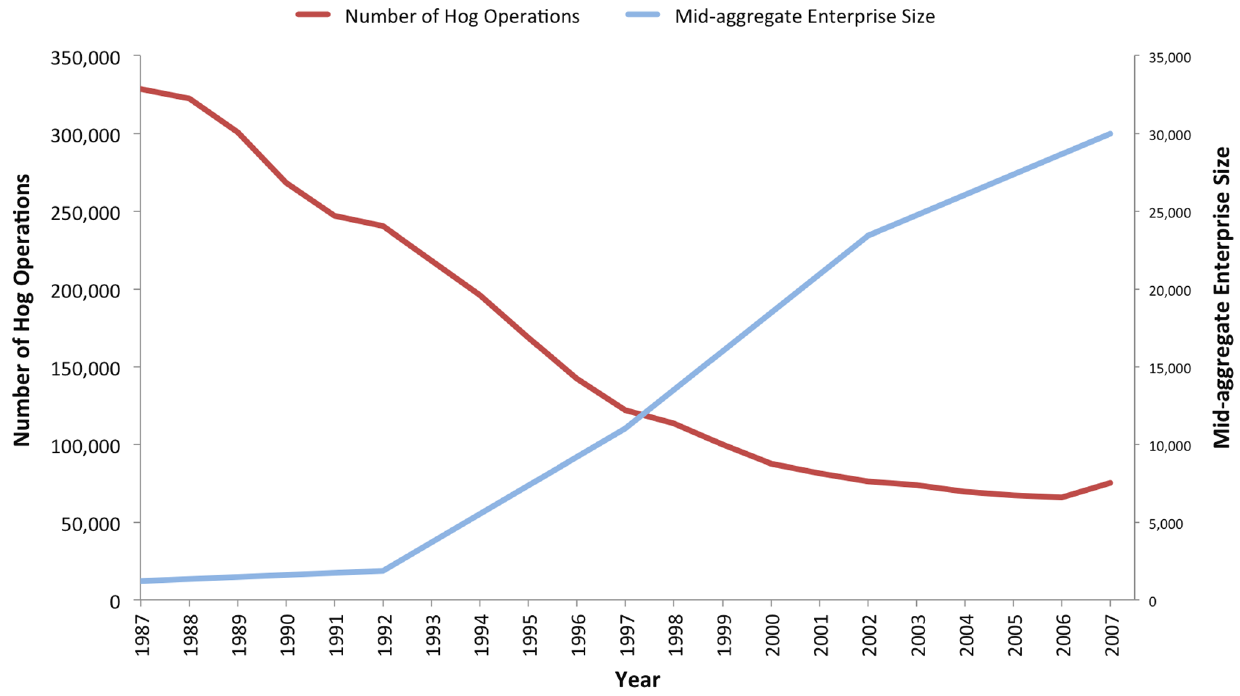
Figure 1. Hog production in the US: Number of operations and mid-aggregate enterprise size; 1987–2007. Data from the United States Department of Agriculture (USDA) shows the decline in number of hog operations and growth in operation size from 1987 to 2007. Sources: The Changing Organization of U.S. Farming, USDA Economic Research Service (http://www.ers.usda.gov/amber-waves/2011-december/changing- farming-practices.aspx # .UgqVWOu9xEo) and USDA Census of Agriculture QuickStats, various years (http://quickstats.nass.usda.gov/?source_ desc=CENSUS).